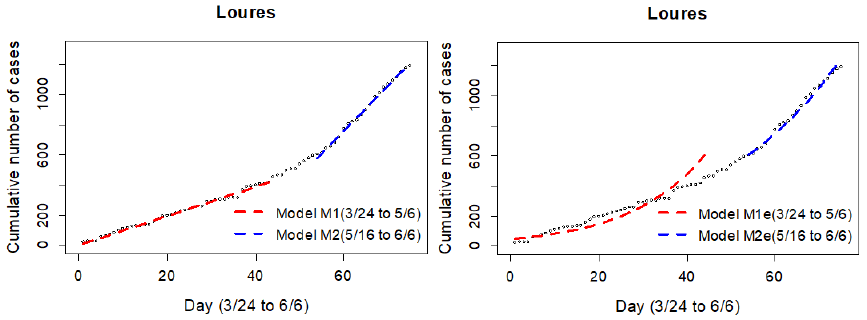
Figure 7. Linear ( left ) & exponential ( right ) models, fit to S 1-extended (3/24–5/6) and S 3